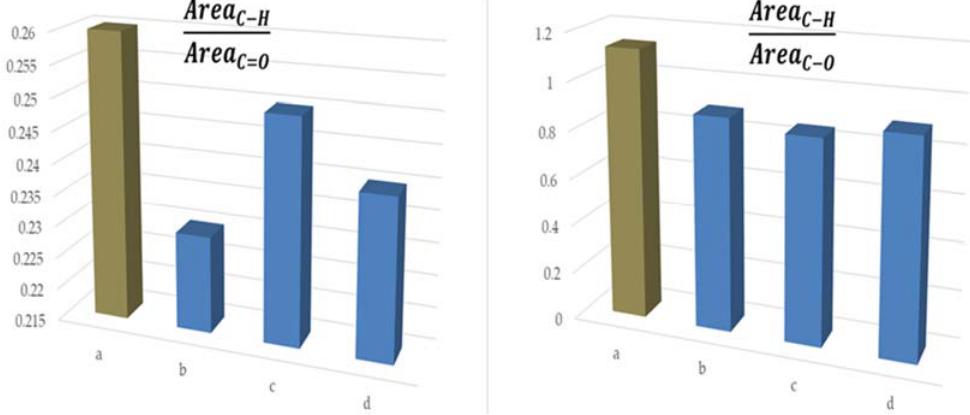
Figure 5. Intensity ratios I 2945 /I 1715 and I 2945 /I 1330 evaluated as an integrated area for ( a ) untreated PBS, ( b ) O 2 ‐ plasma ‐ treated for 30 s, ( c ) O 2 ‐ plasma ‐ treated for 30 s and Ar post ‐ crosslinking for 60 s, and ( d ) O 2 ‐ plasma ‐ treated for 30 s and Ar post ‐ crosslinking for 120 s.